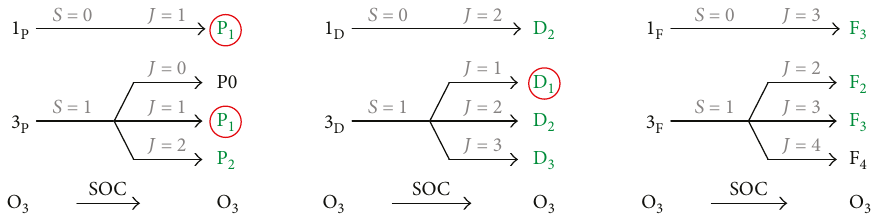
Figure 9: Splitting of the fi nal state terms 1,3 P, 1,3 D, and 1,3 F due to spin-orbit coupling for Ti 4+ .